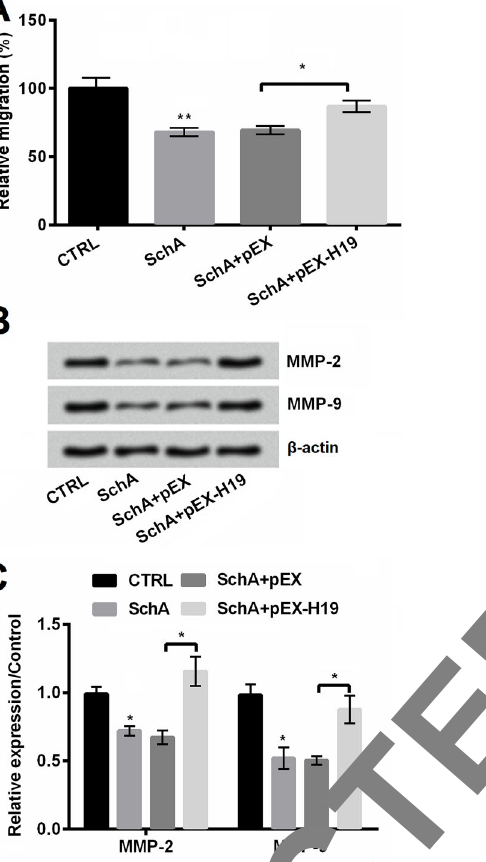
Figure 6. Schizandrin A (SchA) decreased cell migration by down-regulating H19. A , Cell migration was detected by transwell two-chamber assay. MMP-2 and MMP-9 protein levels were detected by western blot ( B ) and analyzed quantitatively ( C ). b -actin was used as control. Data are reported as means ± SD (n=3). *P o 0.05 and **P o 0.01 compared to control or as indicated (ANOVA and Student ’ s t -test).